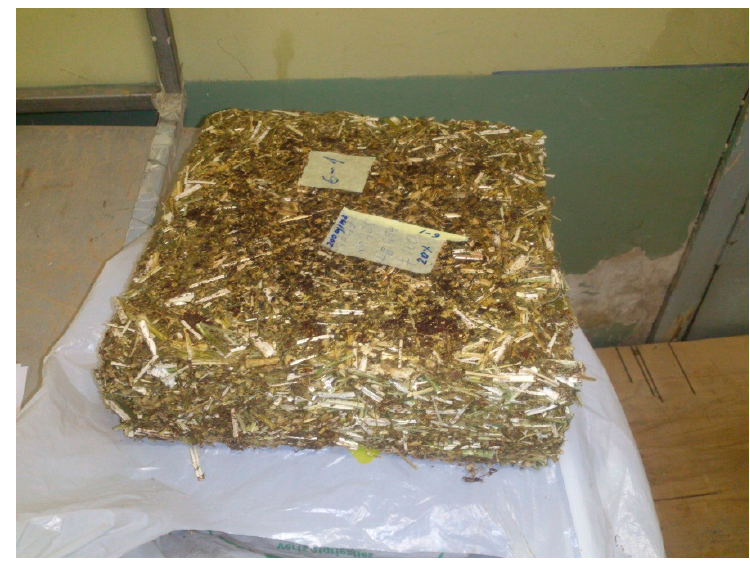
Figure 2. Slabs of hemp fibers with dimensions of 300 × 300 mm.